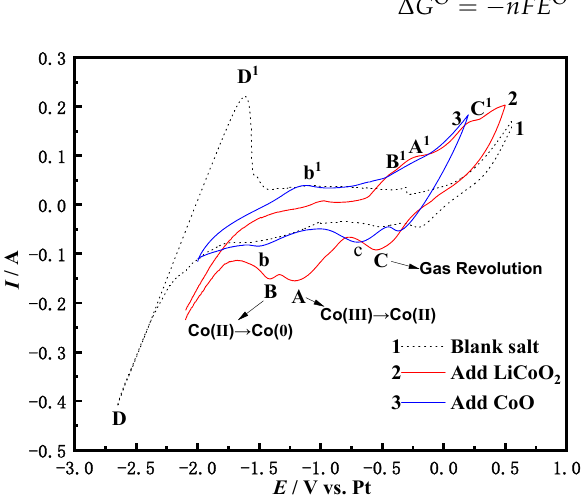
Figure 1. Cyclic voltammetry comparison of pure salt in NaCl-CaCl 2 -LiCoO 2 molten salt and addi- tion of oxide (0.2 V/S; WE: Fe electrode).